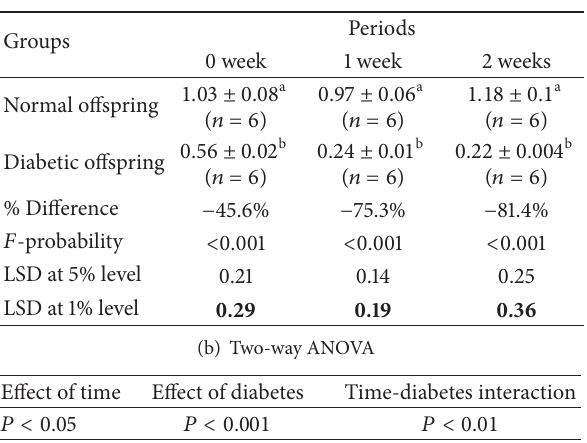
Table5:HO1MA 𝛽 -cellfunctionofoffspringofnormalanddiabetic dams at different experimental periods.